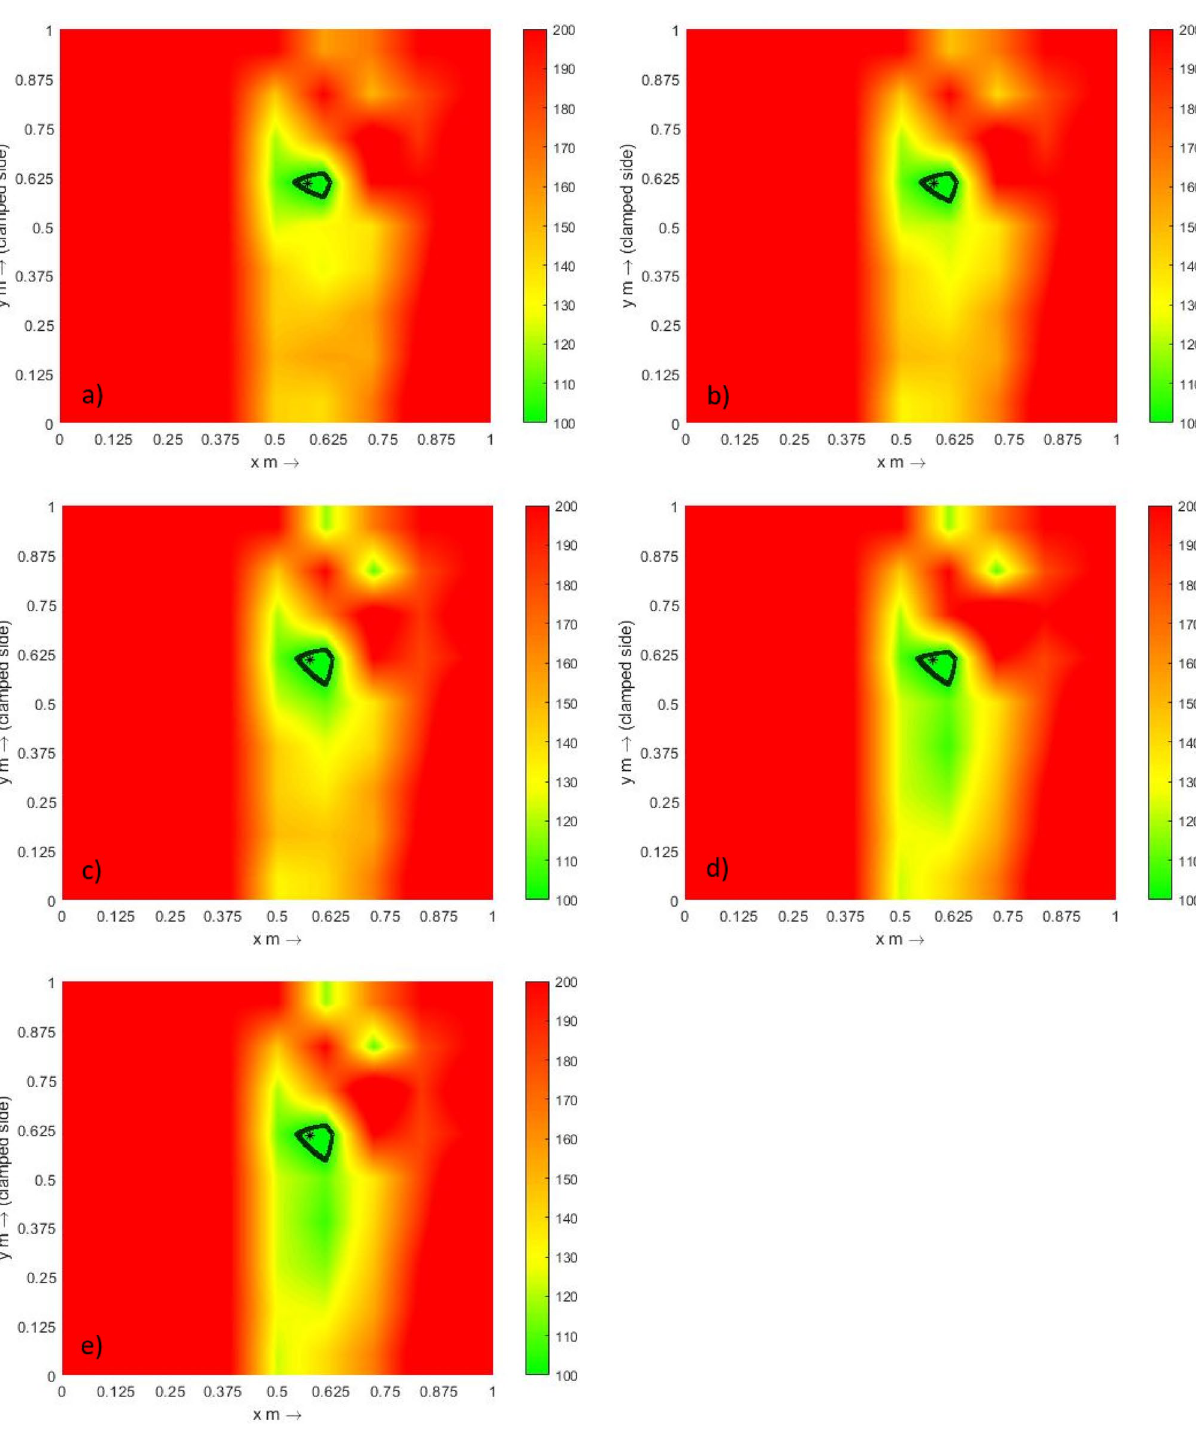
Fig. 13 Estimated region of the position of load applied for test point B using a finer grid with a deflection of a 5 mm, b 10 mm, c 15 mm, d 20 mm and e 25 mm. Asterisk marks the actual position of applied